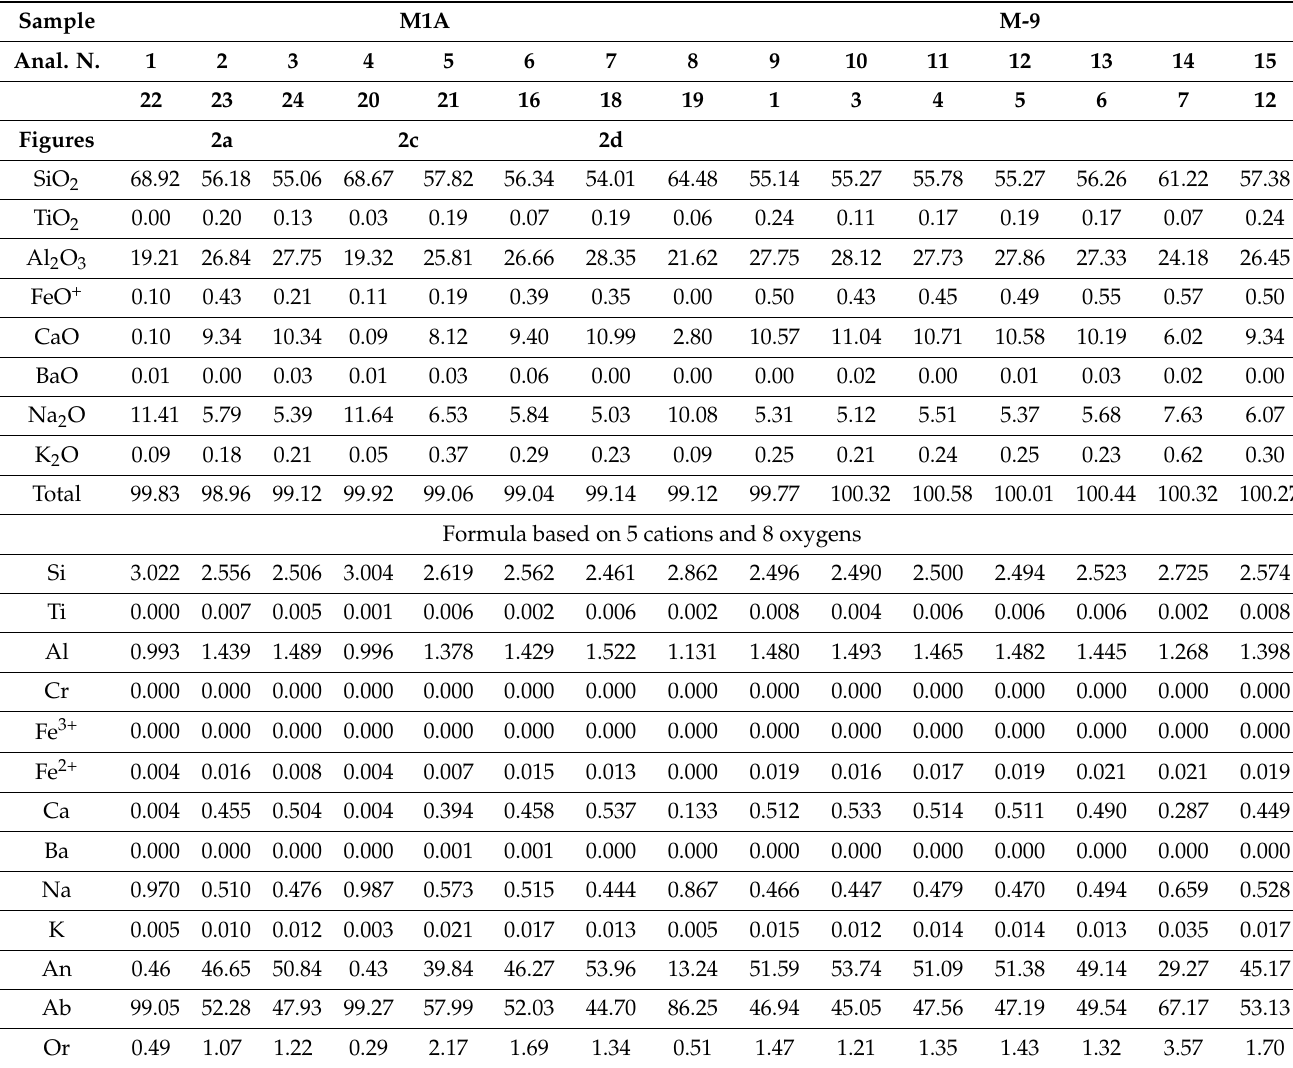
Table 5. Selected analyses of